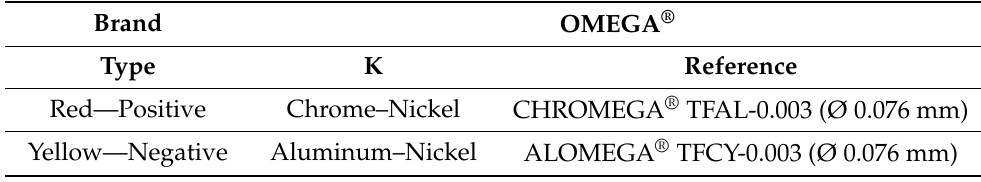
Table 3. Characteristics of thermocouples.